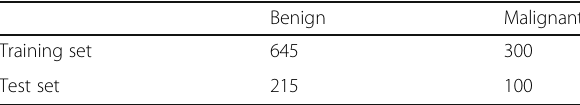
Table 1 2D diffuse optical tomography image dataset and its division into training and test